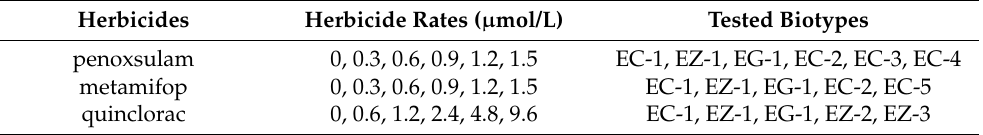
Table 3. Herbicide rates for screening the discriminating rates of the three